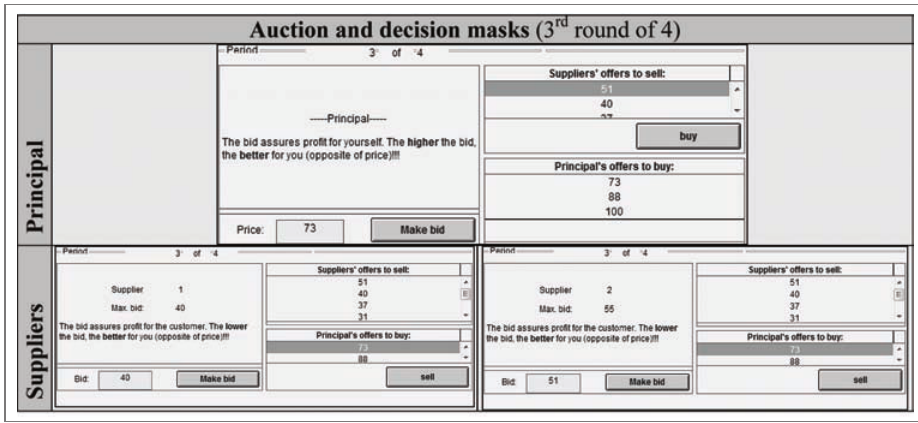
Fig. 5. 2-step initial bargaining: irrevocable determination of the supplier, profit division with